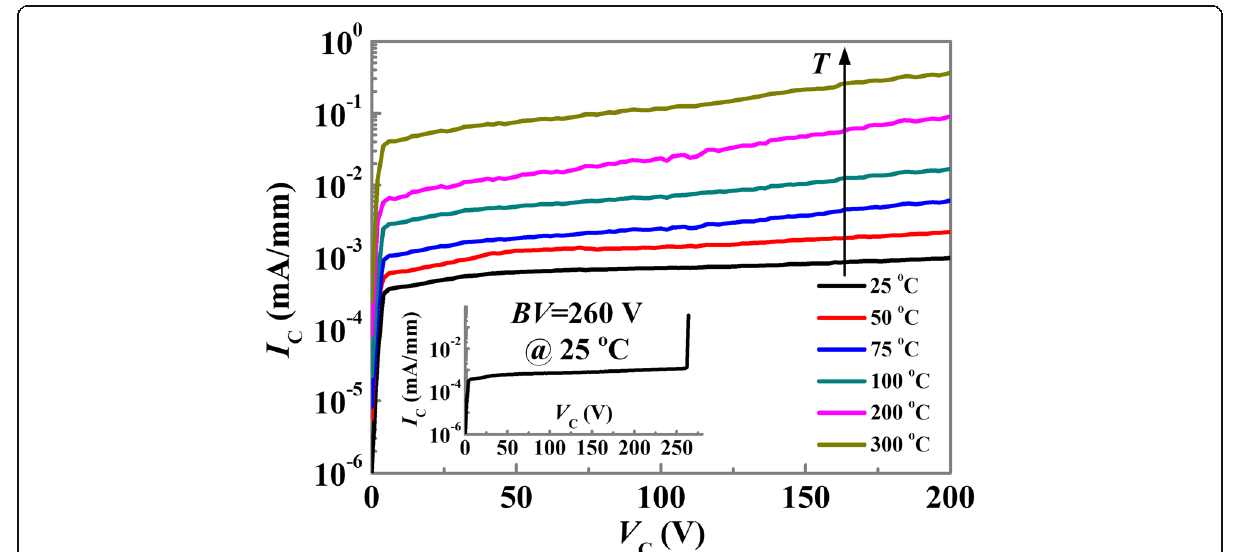
Fig. 6 Temperature dependent reverse bias I - V characteristics of the